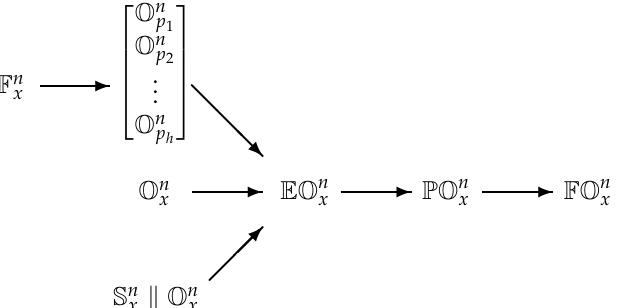
Figure 3. Hierarchy of data streams in the stream fusion framework. Heterogeneous data streams are consolidated and merged with every step of the stream fusion (depicted from left to right). Raw data streams ( F n x , O n x and S n x ) are transformed, enriched and resampled into coherent data streams EO n x and then fused through partial feature vector streams PO n x into a final full feature vector data stream FO n x